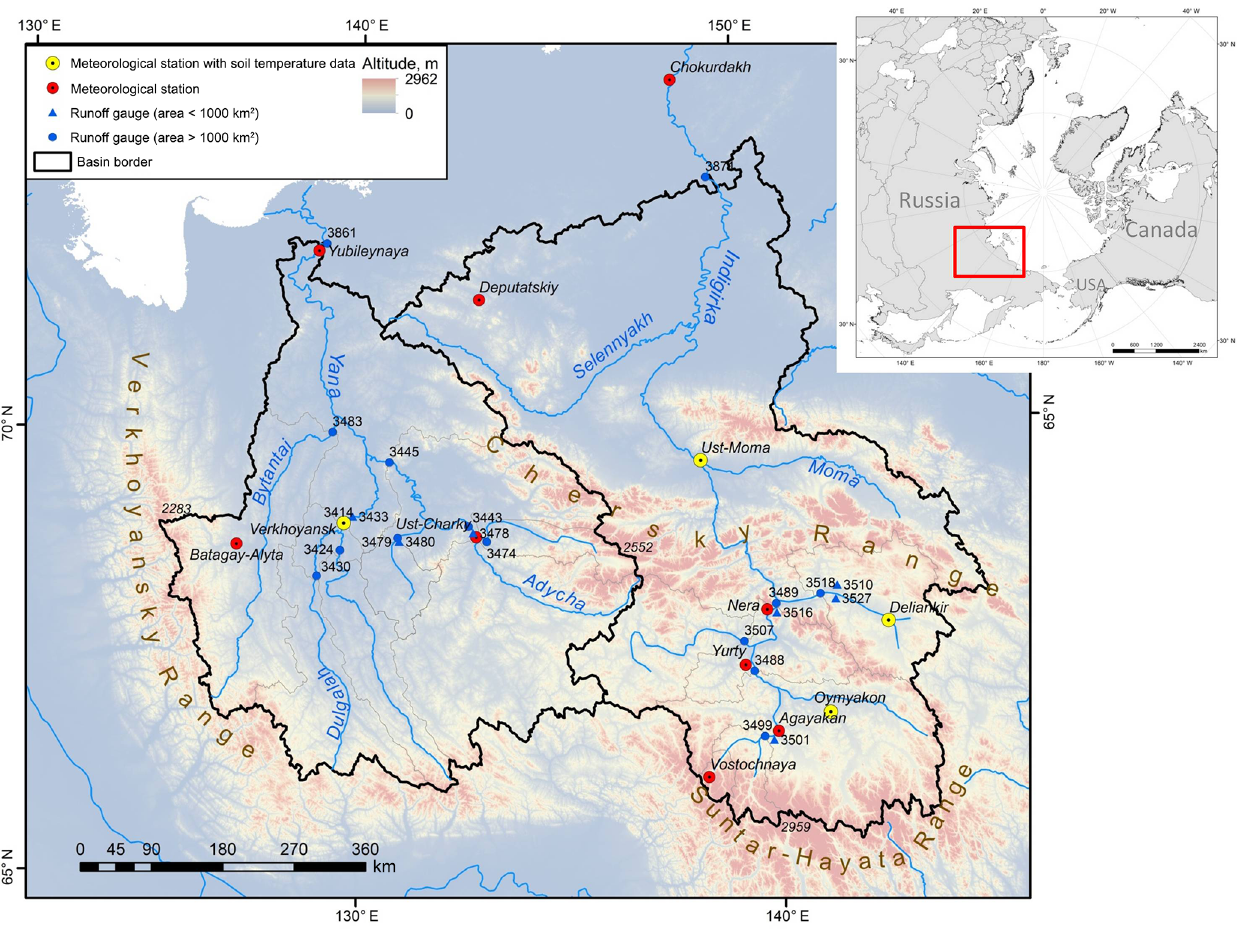
Figure 1. Meteorological stations and hydrological gauges within the study